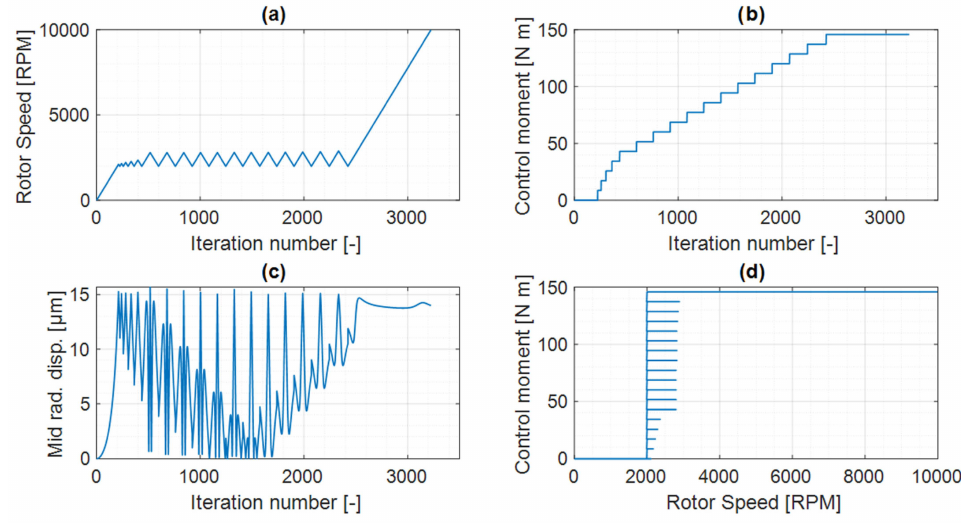
Figure 13. Path taken by the algorithm to optimise the actuator moment using the adjusting speed ap- proach ( a ) Rotor speed at each iteration ( b ) Actuator moment at each iteration ( c ) Radial displacement at each iteration ( d ) Actuator moment at each speed.